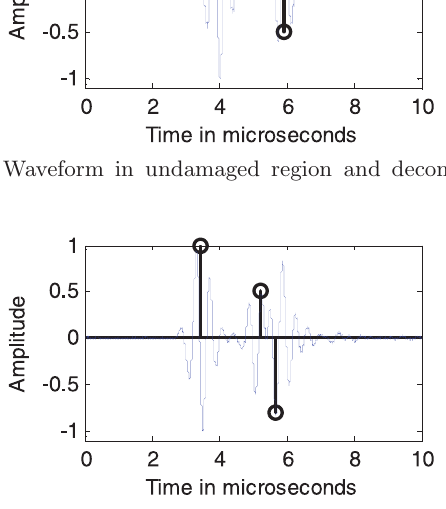
Fig. 7. Waveform in damaged region and deconvolution result (closely echoes in back wall region).